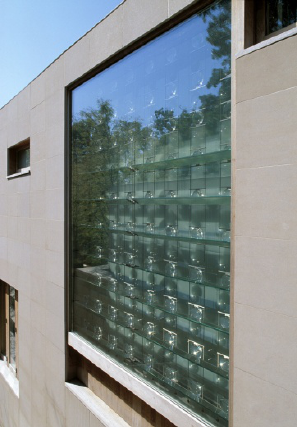
Figure 8: view of the window during installation. Figure 9: the completed window seen from